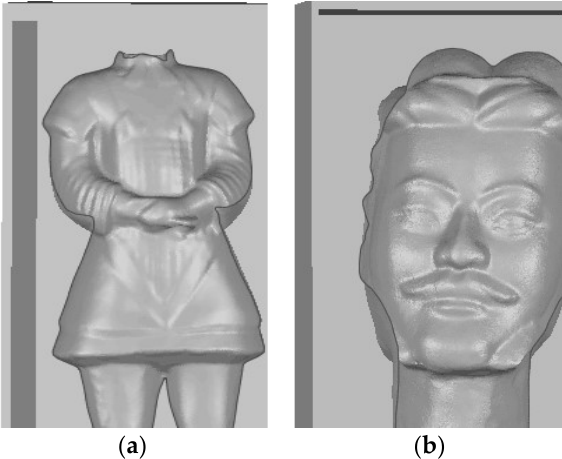
Figure 9. A sample of the packing for transportation . ( a ) Body, ( b ) Head .